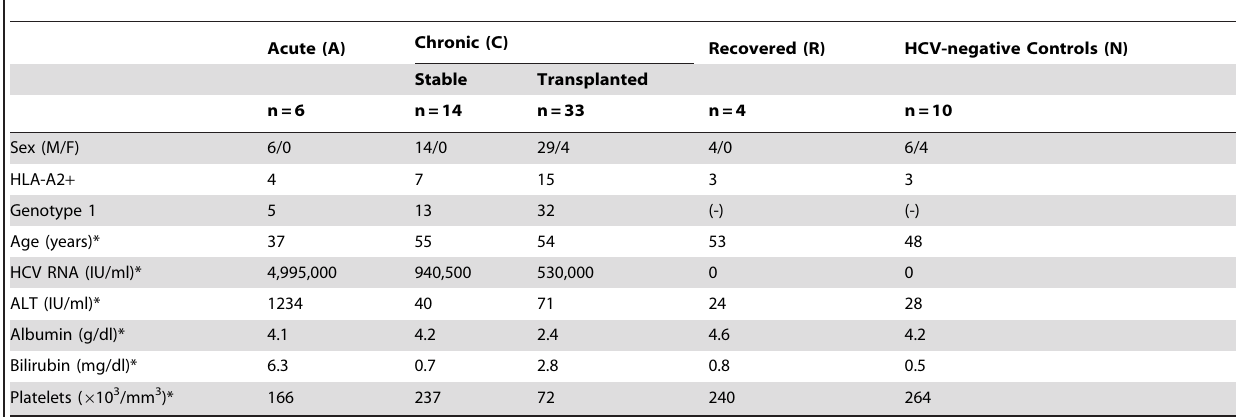
Fluorescent antibodies and